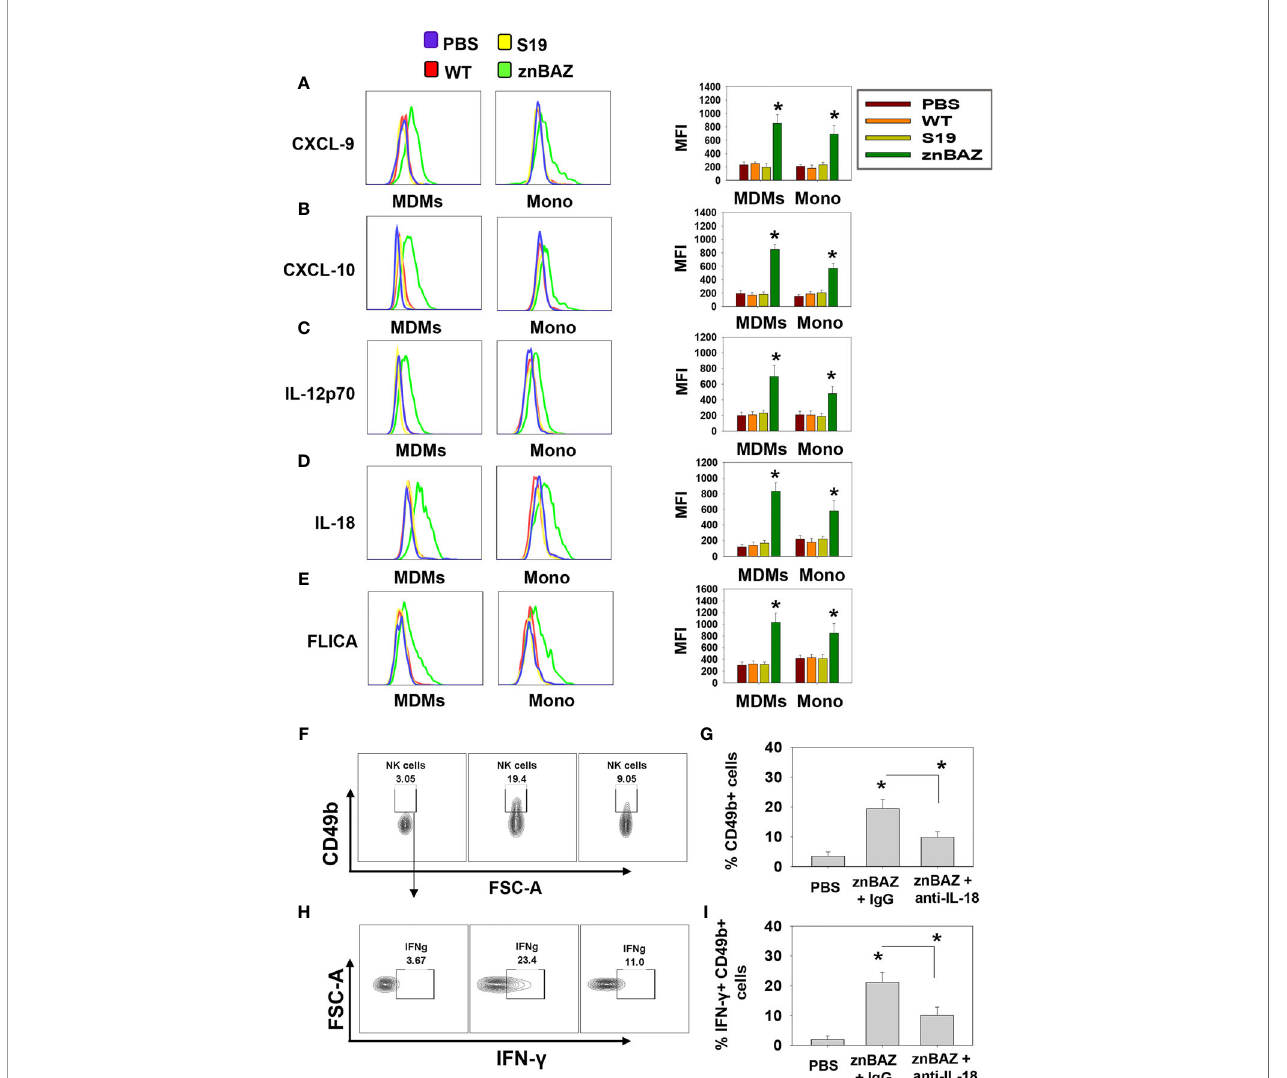
FIGURE 3 | The source of CXCL-9, CXCL-10, IL-12, and IL-18 are from monocyte-derived macrophages (MDMs) and monocytes (Mono). (A – E) Flow cytometry analysis of lung MDMs and monocytes was performed three days after infection to determine the source and mean fl uorescence intensity (MFI) of CXCL-9, CXCL- 10, IL-12p70, IL-18, and activation of caspase-1 (FLICA-positive) cells. Flow cytometry analysis of lung (F, G) CD49b + and (H, I) IFN- g -producing CD49b + NK cells on day 5 post-znBAZ infection of BALB/c mice i.p treated with anti-IL-18 mAb or an equivalent amount IgG isotype control on days -1 and +2. The data depict the means ± SEM of 5 mice/group; *p < 0.01 compared with PBS-dosed mice or as indicated. Data are representative of two or three